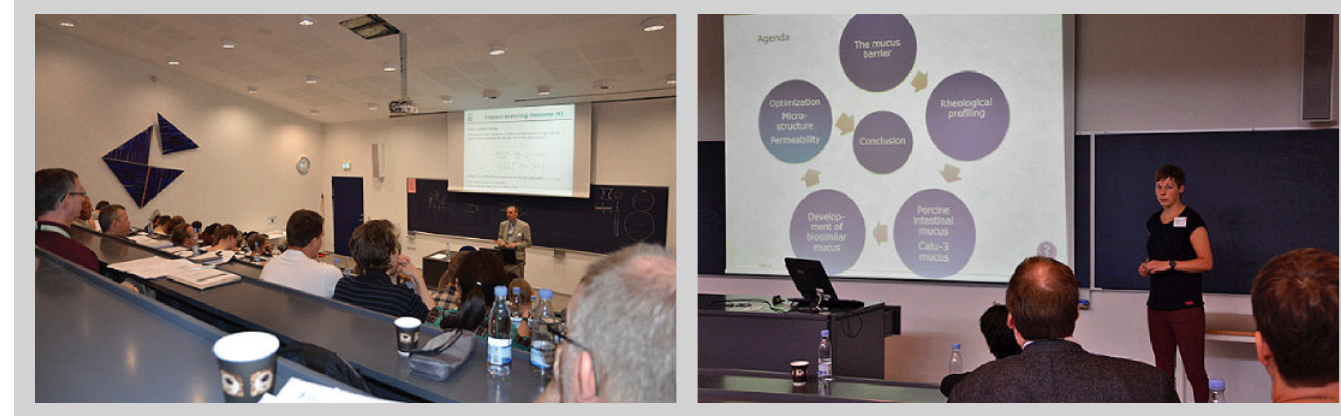
Figure 1 (left): Conference hall. Figure 2 (right): Presentations and discus- sions. Figure 3 (next page, left above): Audience. Figure 4 (next page, right above): Coffee break. Figure 5 (next page, left below): Poster session. Figure 6 (next page, right below): Conference